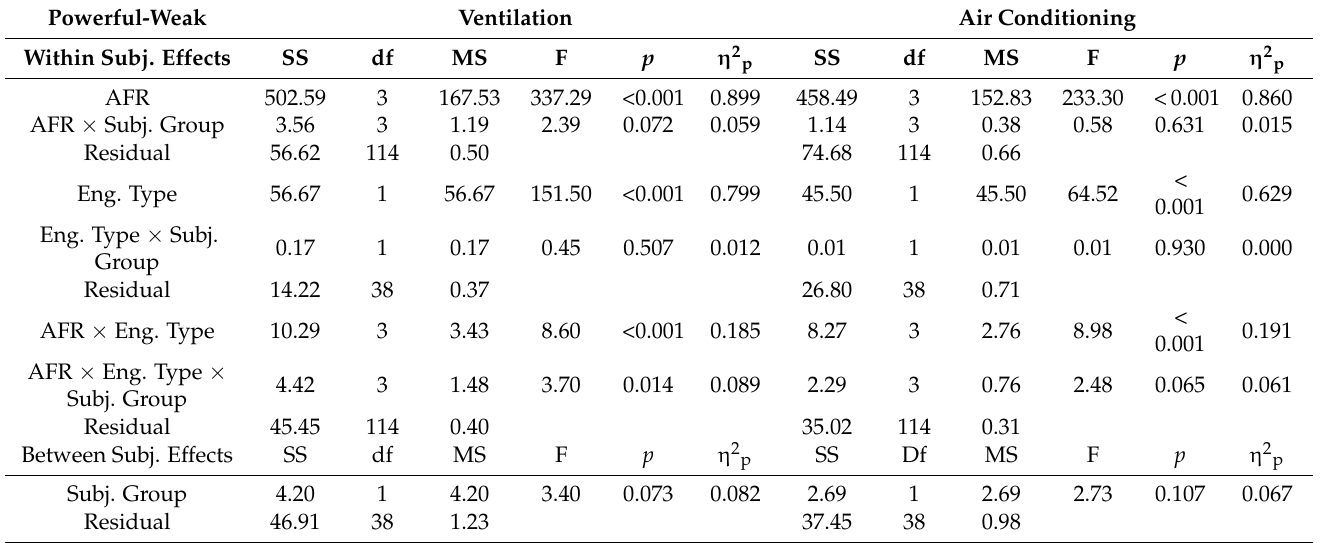
Table 7. ANOVA results for Powerful-Weak